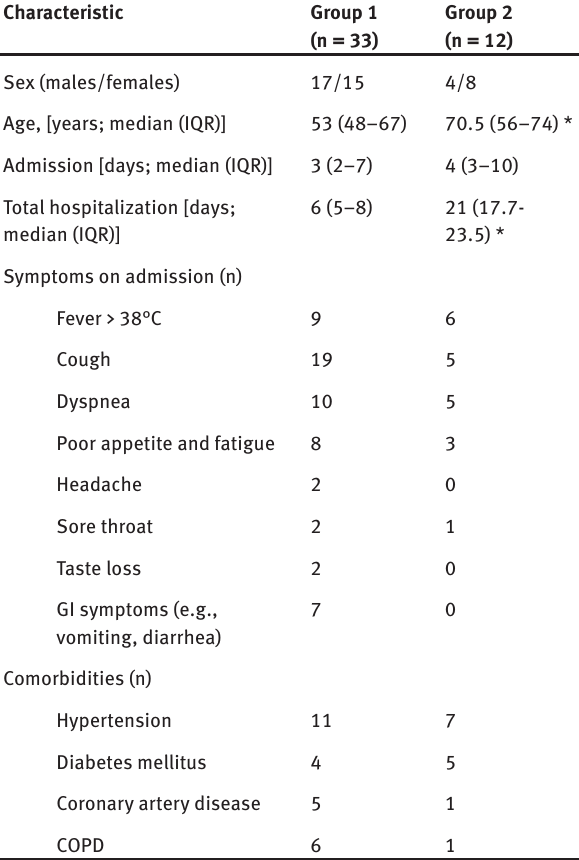
Table 1 : The characteristics of the 45 patients with COVID-19.